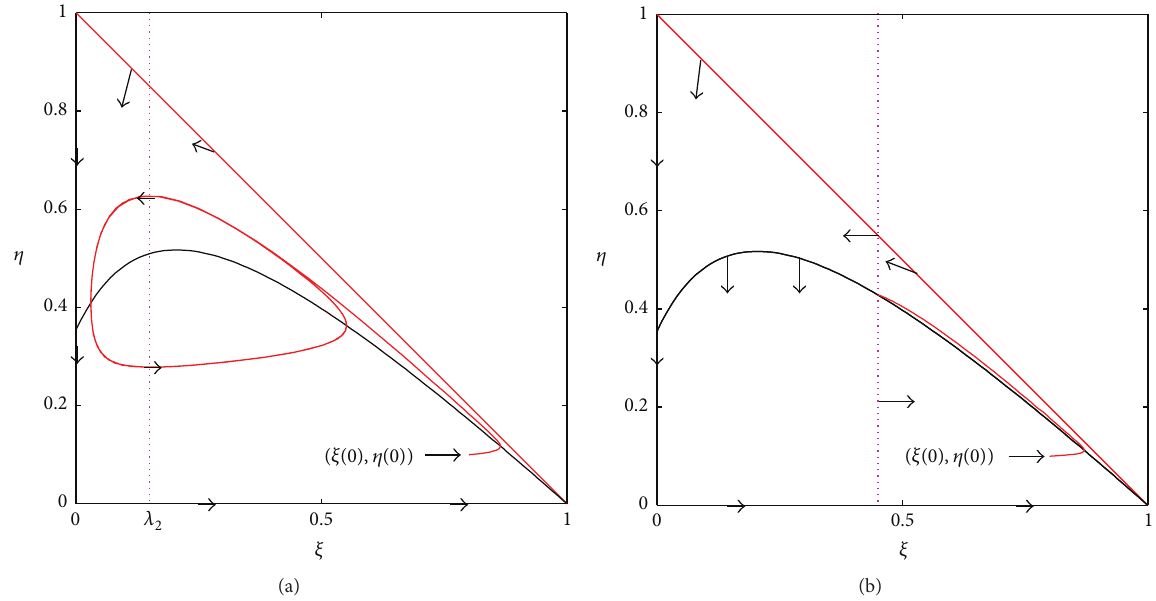
Figure 2: (a) System (21) has at least one limit cycle if ̃𝜂 󸀠 (𝜆 2 ) > 0 and (C-I)–(C-VI). The interior fixed point of system (21) is locally asymptotically stable when ̃𝜂 󸀠 (𝜆 2 ) < 0 and (C-I)–(C-VI). Our prototype example (18) is indeed globally asymptotically stable if ̃𝜂 󸀠 (𝜆 2 ) < 0